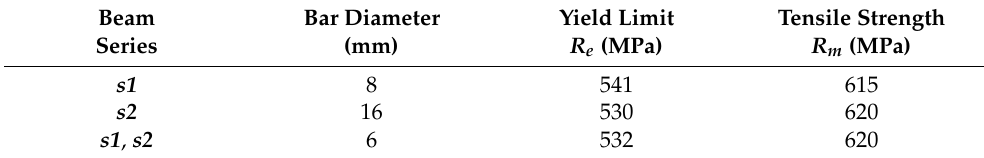
Table 2. Tensile strength of reinforcement steel.